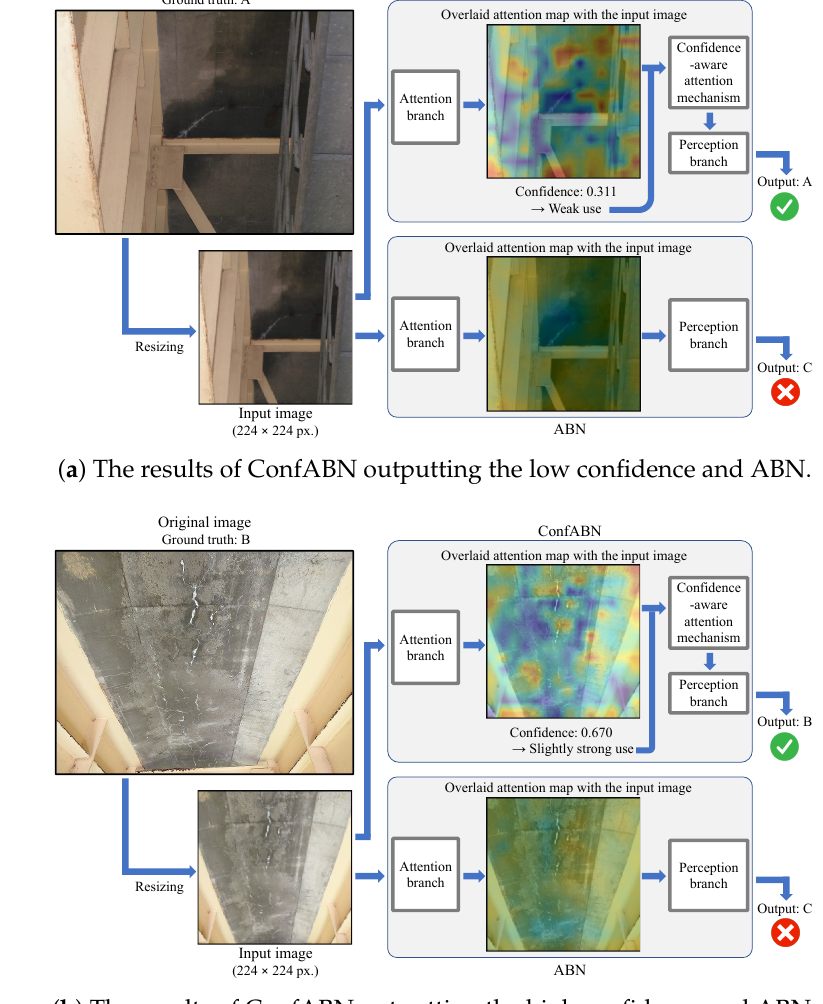
Figure 5. Examples of the estimation results using ConfABN and ABN for the images of